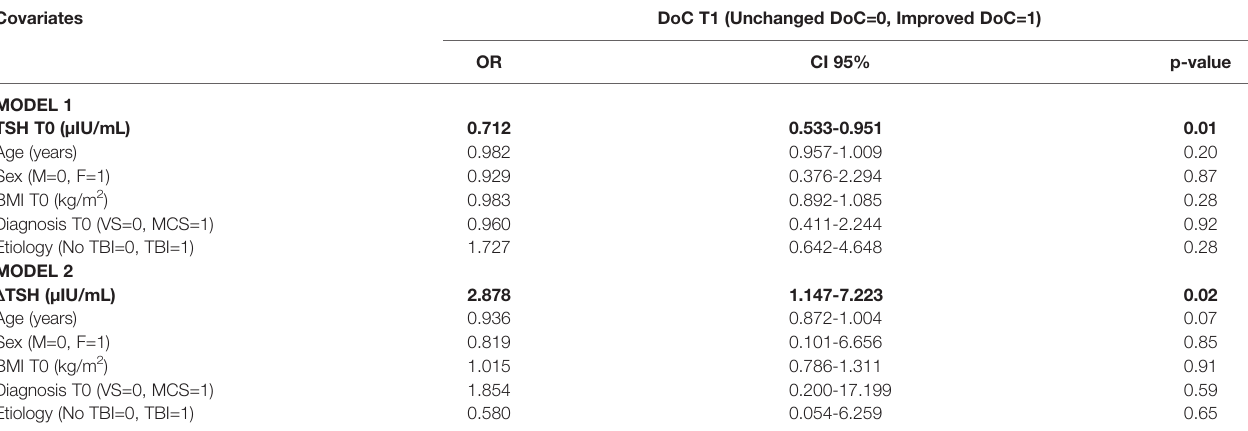
TABLE 3 | Multivariable logistic regression analysis showing independent predictors for DoC evolution in the population as a whole. Covariates